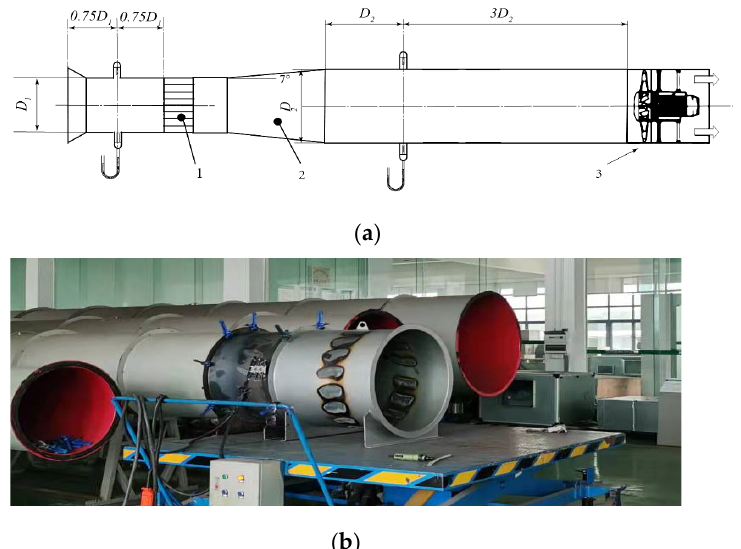
Figure 5. Aerodynamic performance experimental setup: ( a ) schematic diagram of experimental system, 1. rectifying device, 2. expansion tube, 3. expansion tube; ( b ) field diagram of experimental device.